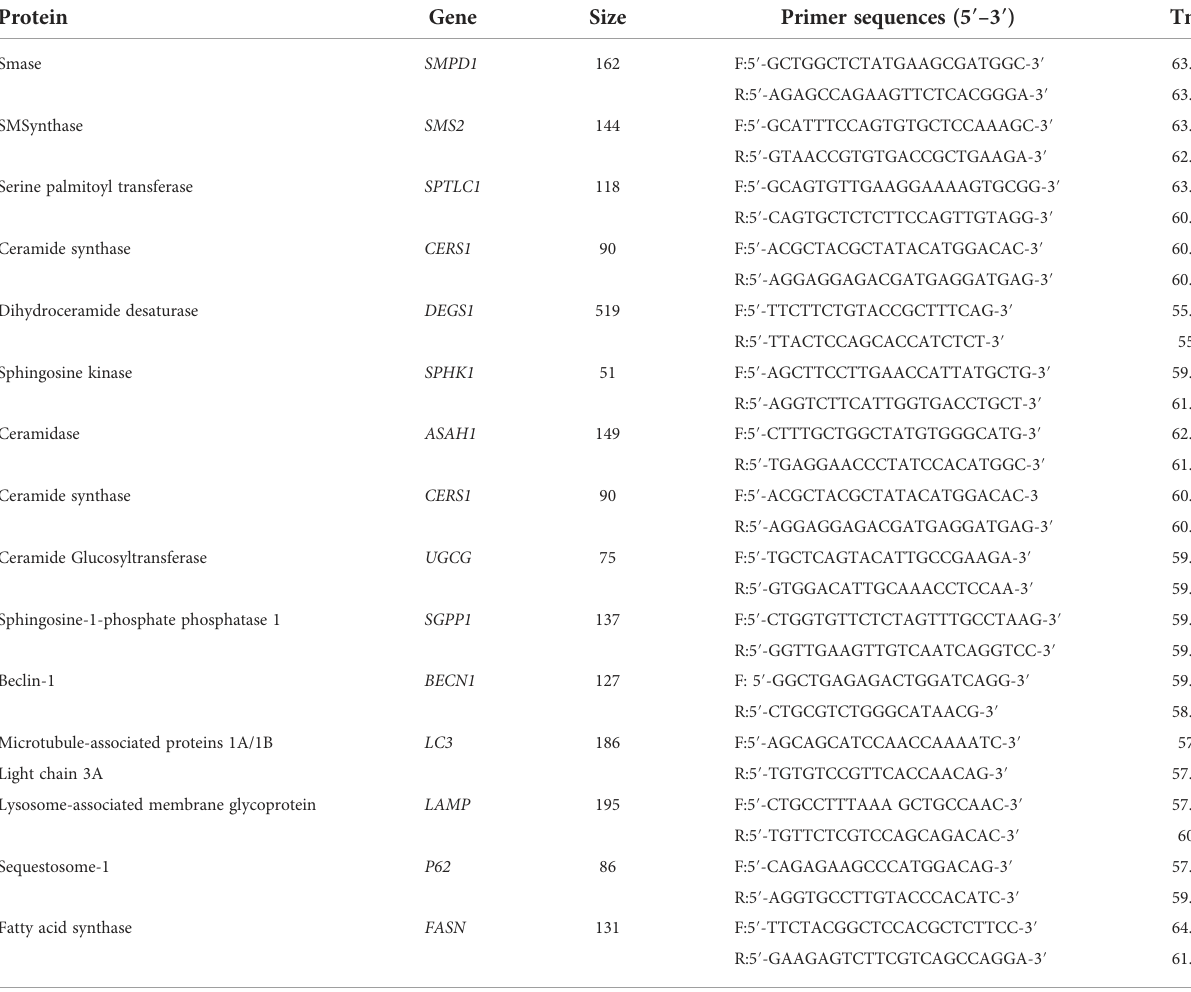
TABLE 1 Gene-related